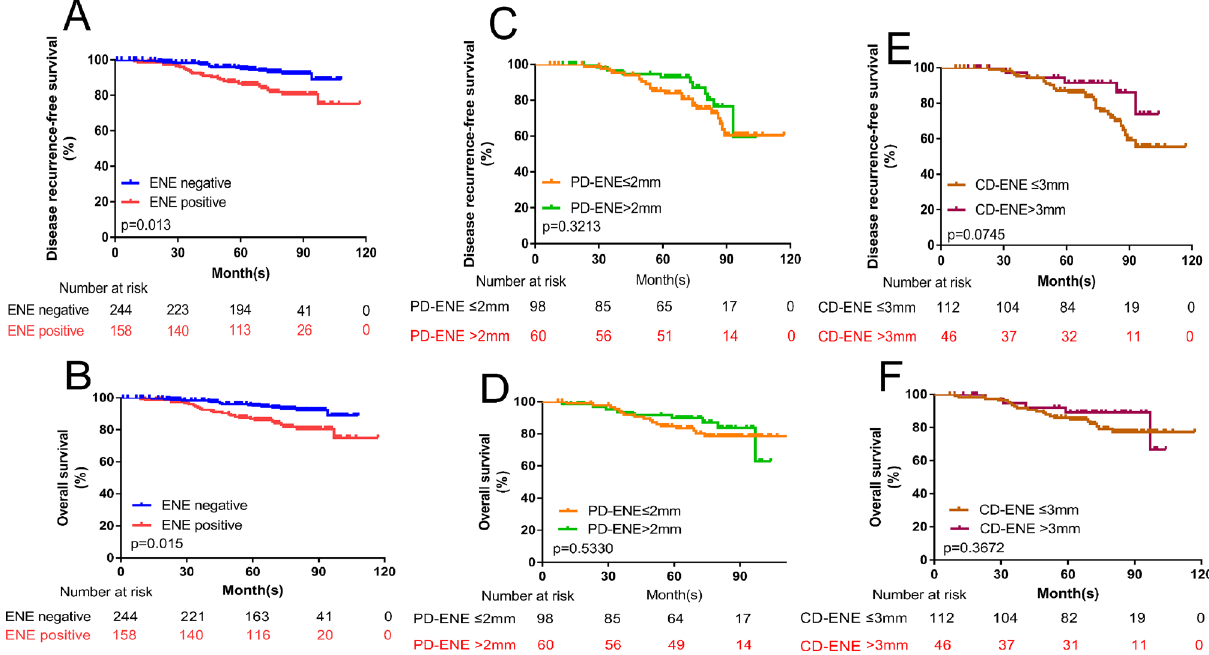
Figure 3. Kaplan–Meier curves and Log-rank test show associations of ENE in ALN with DRFS and OS. ( A , B ) Comparison of survival rate for DRFS (ENE negative group vs. ENE positive group: p < 0.0001) ( A ) and OS (ENE negative group vs. ENE positive group: p = 0.002) ( B ) Between different ENE groups in whole population. ( C – F ) Comparison of survival rate for DRFS (PD-ENE no larger than 2 mm group vs. PD-ENE larger than 2 mm group: p = 0.632) ( C ) and OS (PD-ENE no larger than 2 mm group vs. PD-ENE larger than 2 mm group: p = 0.345) ( D ) Comparison of survival rate for DRFS (CD-ENE no larger than 3 mm group vs. CD-ENE larger than 3 mm group: p = 0.581) ( E ) and OS (CD-ENE no larger than 3 mm group vs. CD-ENE larger than 3 mm group: p = 0.880) ( F ) between different ENE groups in patients with ENE in